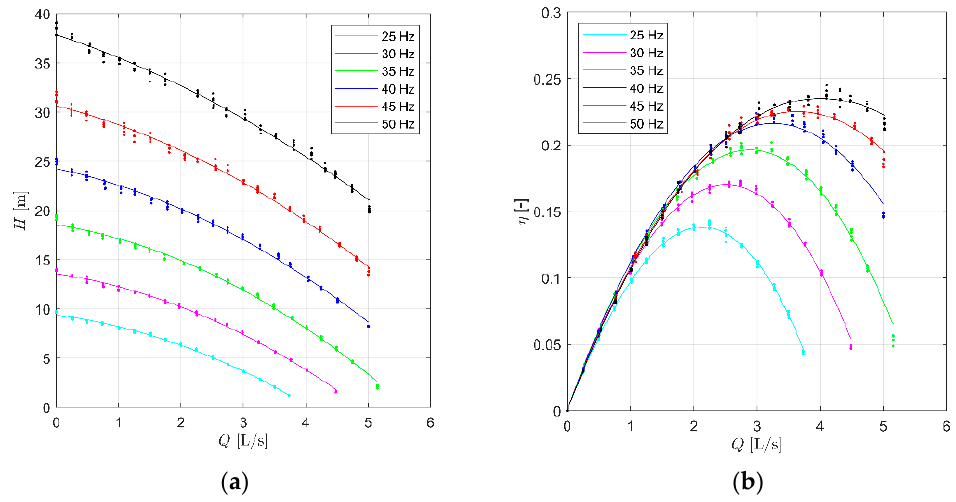
Figure 4. Characteristic ( a ) and efficiency ( b ) curves of the tested pump.